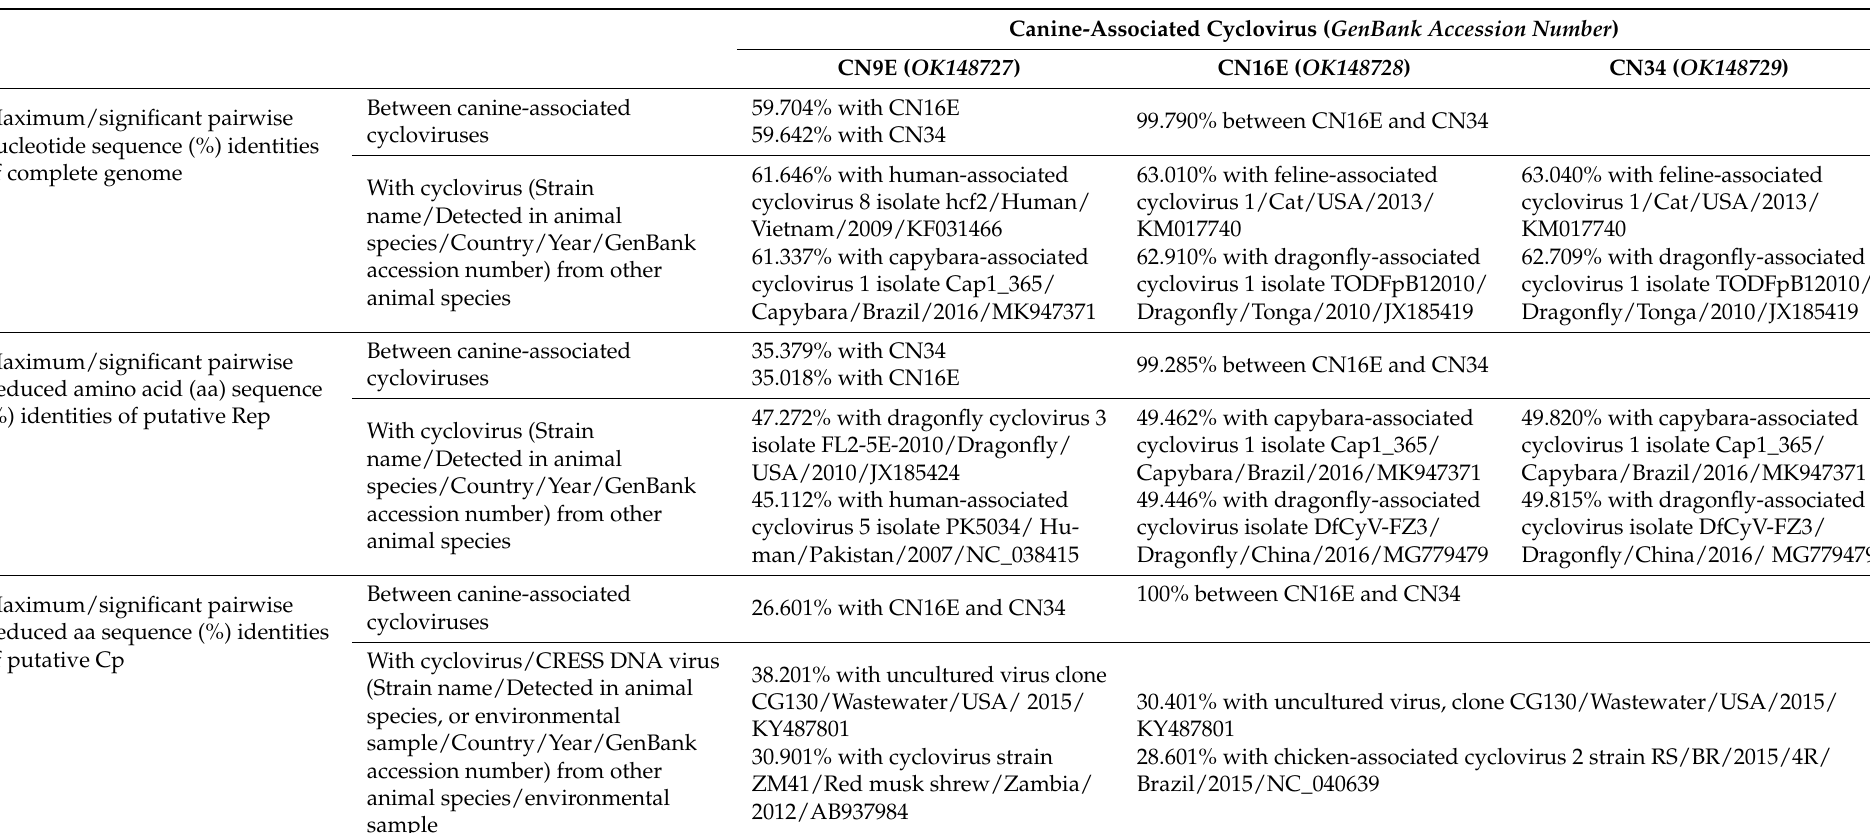
Table 1. Maximum/significant pairwise sequence (%) identities of the complete genomes, putative replication-associated proteins (Rep) and putative capsid proteins (Cp) of canine- associated cycloviruses from domestic dogs between themselves and with those from other animal species or environmental